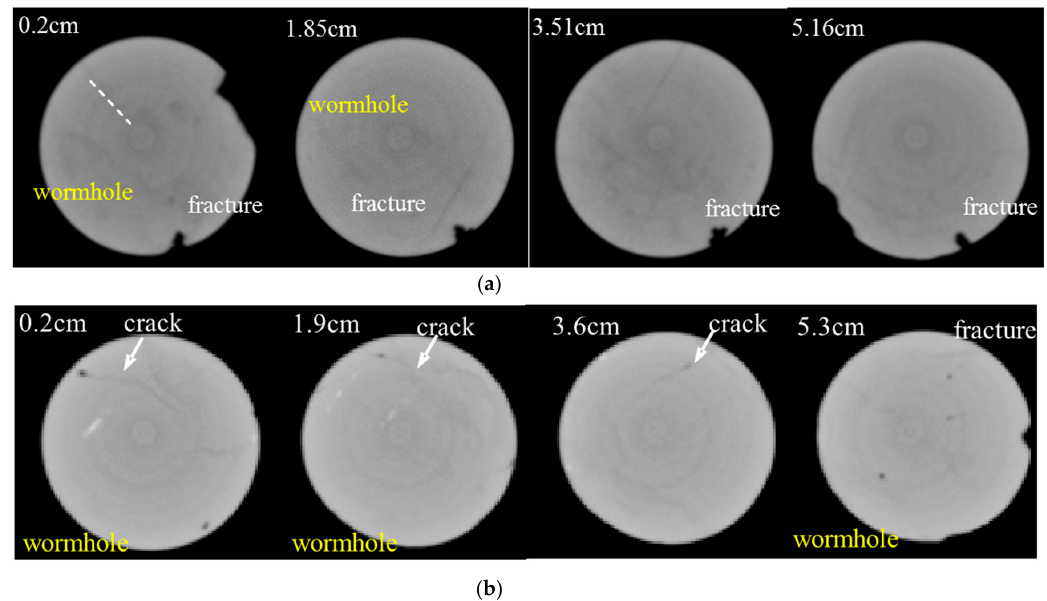
Figure 13. Industrial CT scanning after acid fracturing: ( a ) sample 14 and ( b ) sample 17.